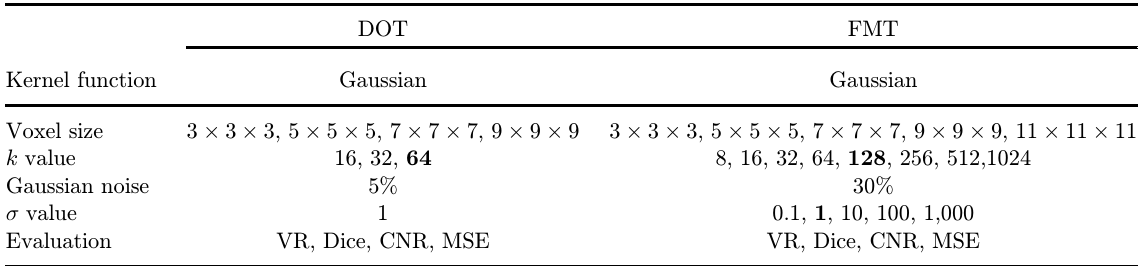
Table 1. Comparison of parameter setup for kernel-based method reconstruction of DOT and FMT. DOT FMT Kernel